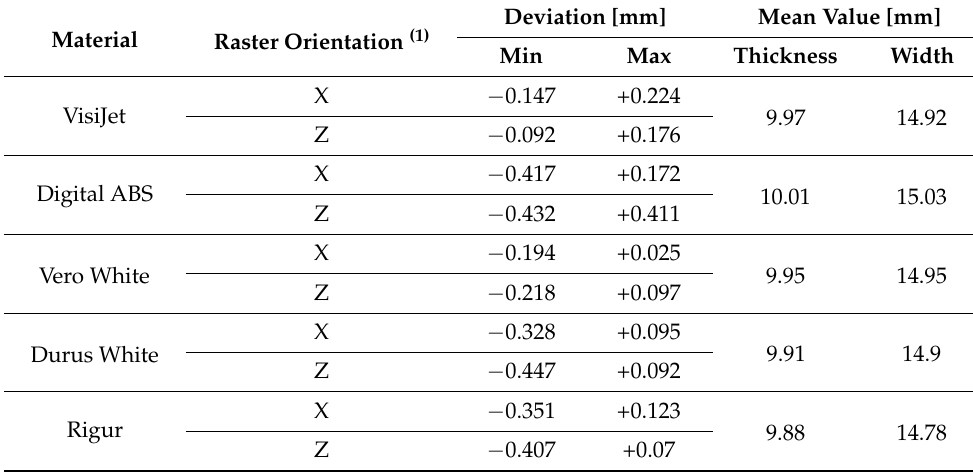
Table 1. Summary of geometry accuracy deviation of specimens for PJ and MJ methods.